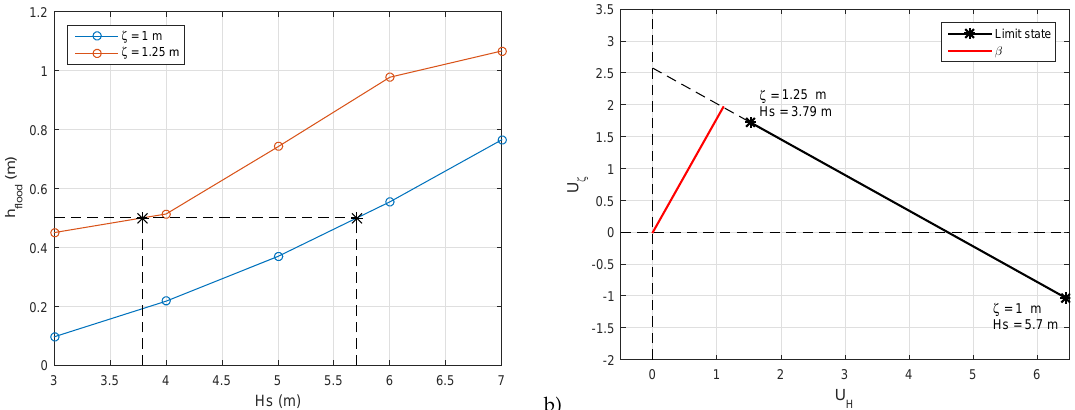
Figure 4. ( a ) Example of evaluation of the limit state in the physical space; and ( b ) limit state in standard space g( U ) and evaluation of the distance β